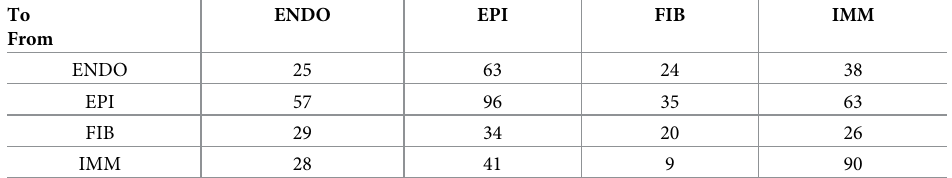
Table 1. Statistics of directed causal edges between different cell types. Rows indicate cell types (endothelial, epithe- lial, fibroblast, and immune cells) from which edges emit and columns represent cell types to which edges point. A number in the table represents the count of edges between two types of GEMs. (summary of edges in S5 Fig). ENDO EPI FIB To From ENDO